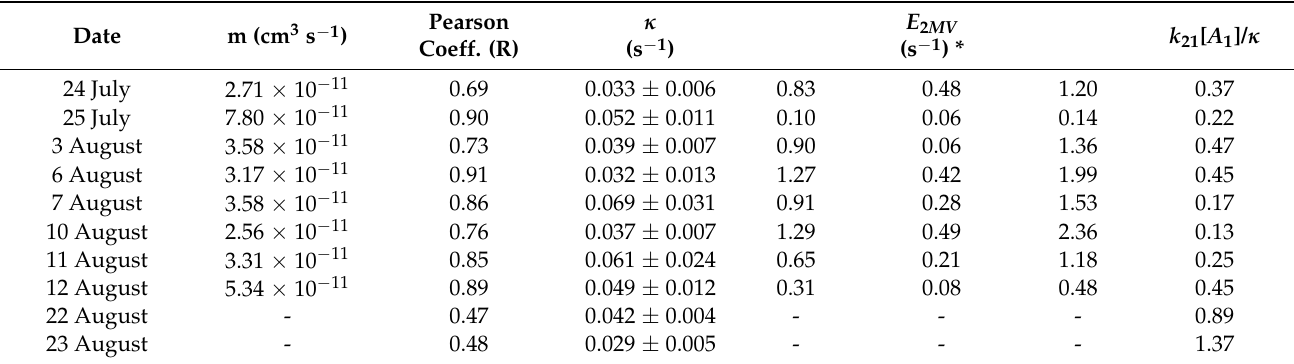
Table 3. The evaporation rates of the more volatile ( MV ) dimers based on the fitting coefficient (m) in Equation (2) for the AA mechanism, along with the correlation coefficient (Pearson) and other